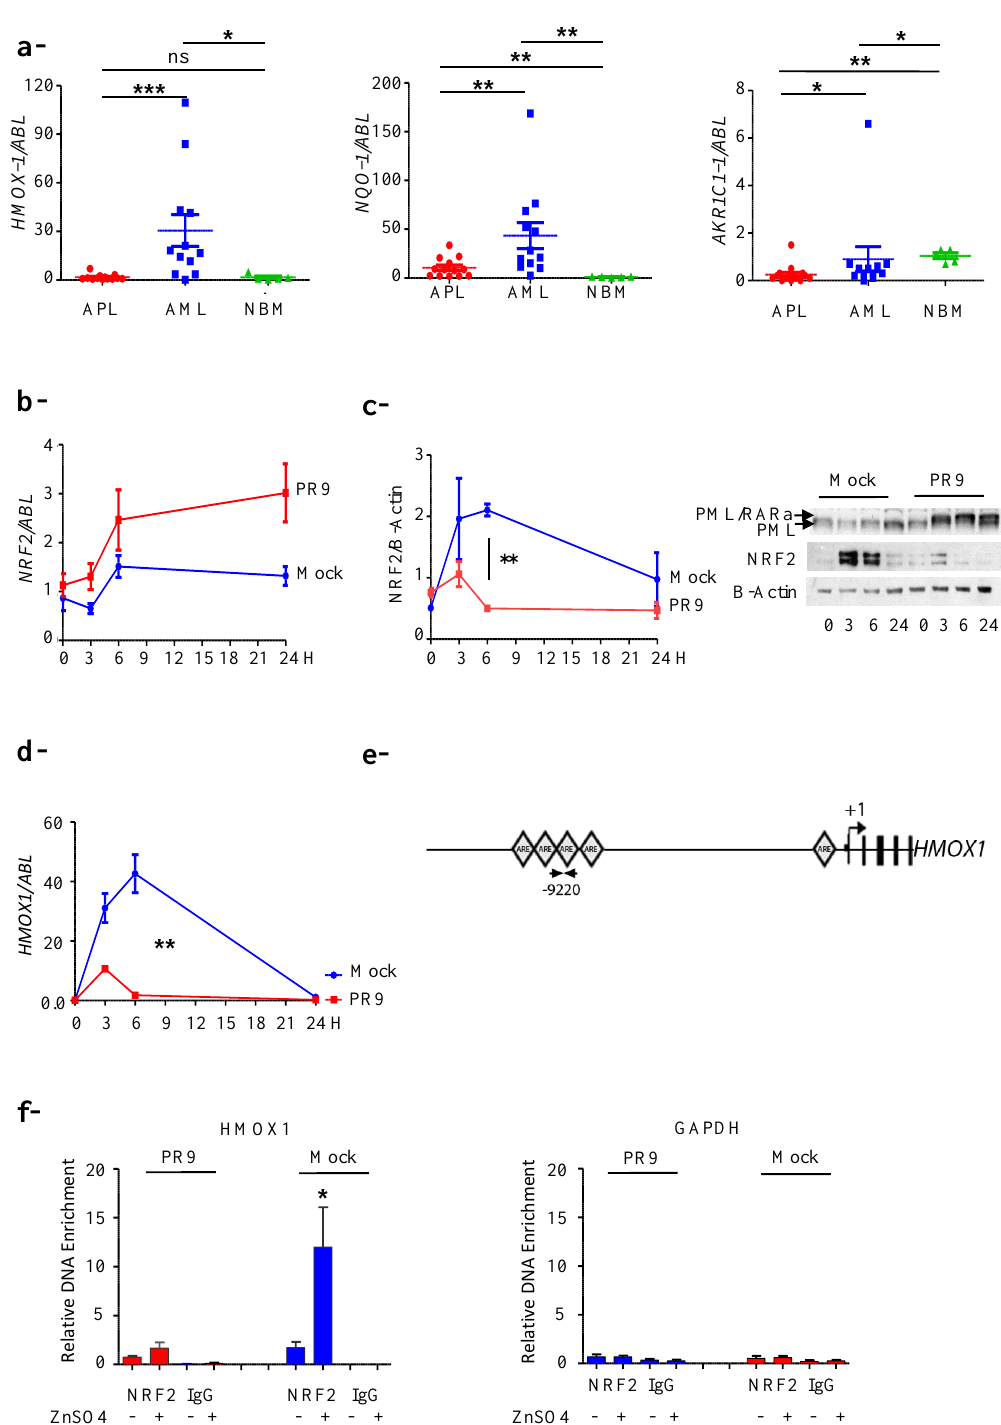
Figure 2. Promyelocytic leukemia / retinoic acid receptor α (PML / RARa) inhibits NF-E2 p45-related factor 2 (NRF2) transcriptional activity by preventing its binding to antioxidant response